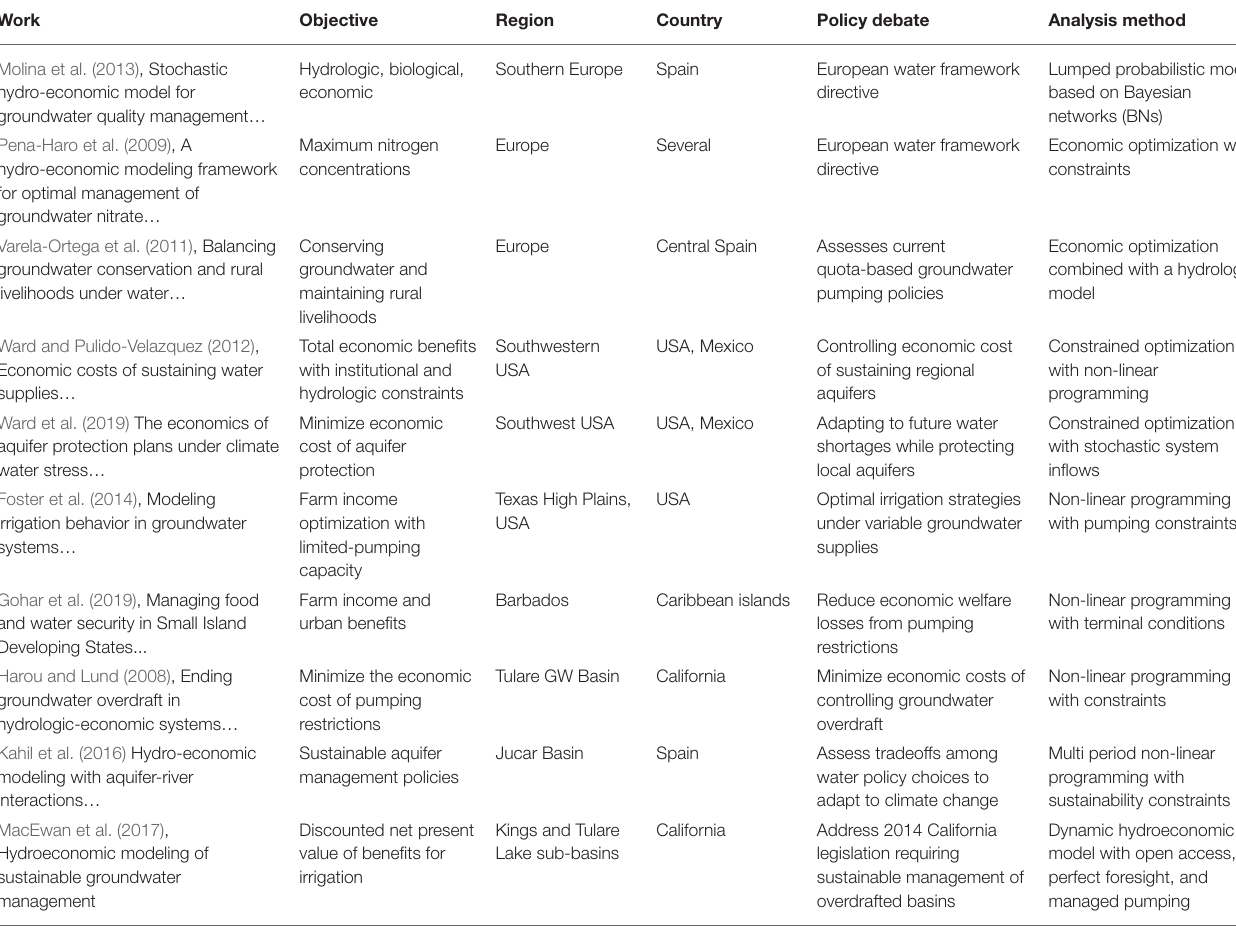
TABLE 1 | Selected hydroeconomic analyses of groundwater pumping adaptations to climate